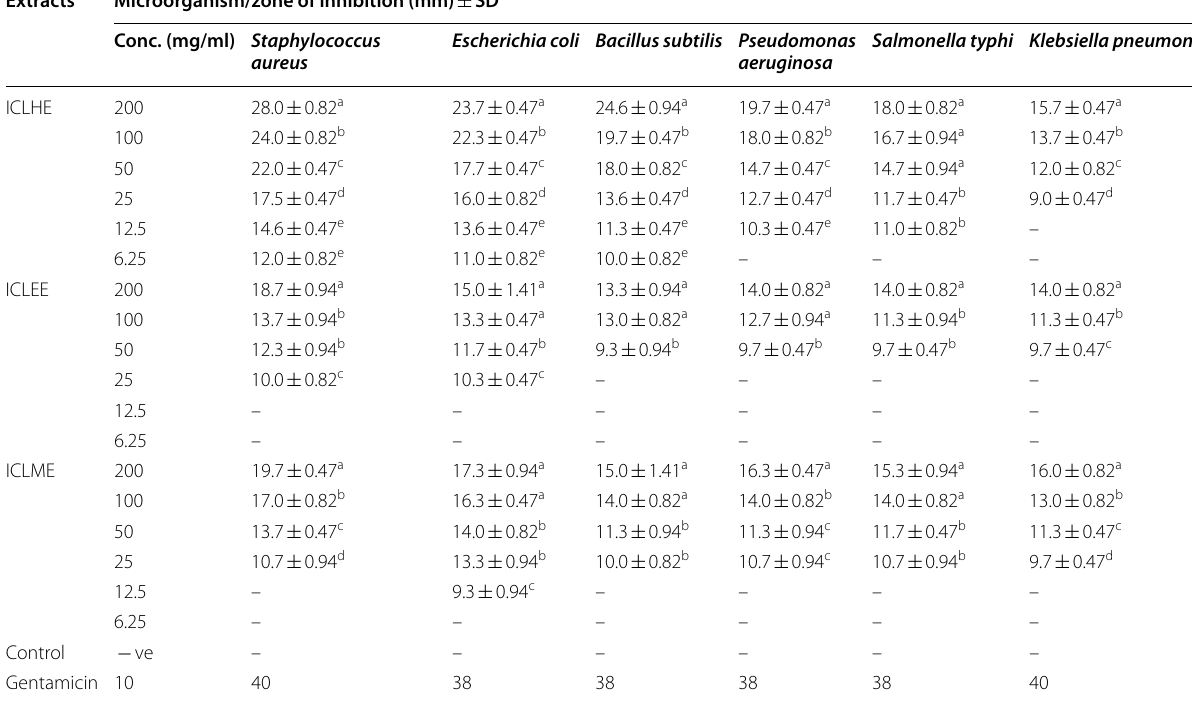
ICLHE-Hexane Extract of I. trichantha leaves; ICLEE-Ethylacetate Extract of I. trichantha leaves; ICLME-Methanol Extract I. trichantha leaves; – No Activity; concentrations with different superscripts are significantly different for each extract ( p < 0.05)